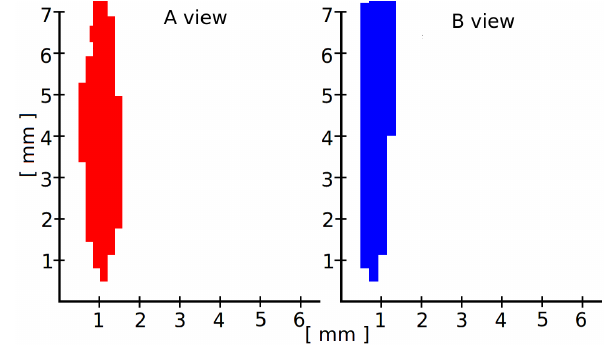
Figure 2. Example of A–B views of a non-realistic particle that needs to be filtered.